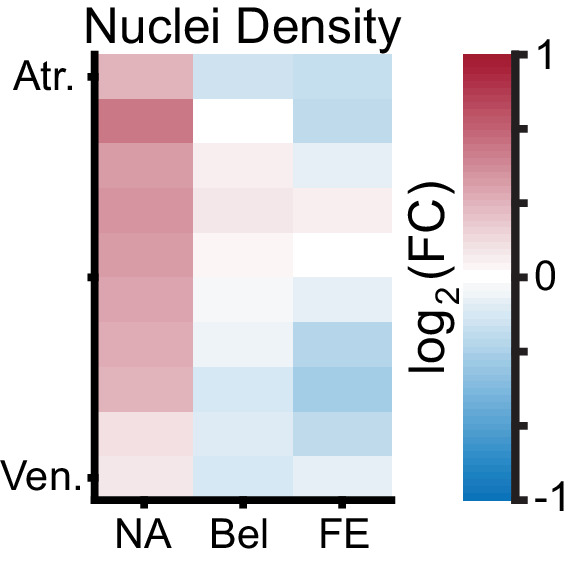
Marginal changes in TIC cellular nuclei density.Heat maps showing regional changes in cell nuclei density. Heat map is separated by regions in radial (near-annulus (NA), belly (Bel), and free edge (FE)) and thickness (atrialis (Atr.), and ventricularis (Ven.)) axes. Fold change (FC) between control (CTL, n = 5) and TIC (n = 19) was determined by the ratio of nuclei densities for each group. Color map indicates the logarithm base 2 of the FC, interpreted as: (positive, red) TIC nuclei density is higher than CTL, (0, white) TIC and CTL nuclei density are approximately equal, and (negative, blue) TIC nuclei density is less than CTL.